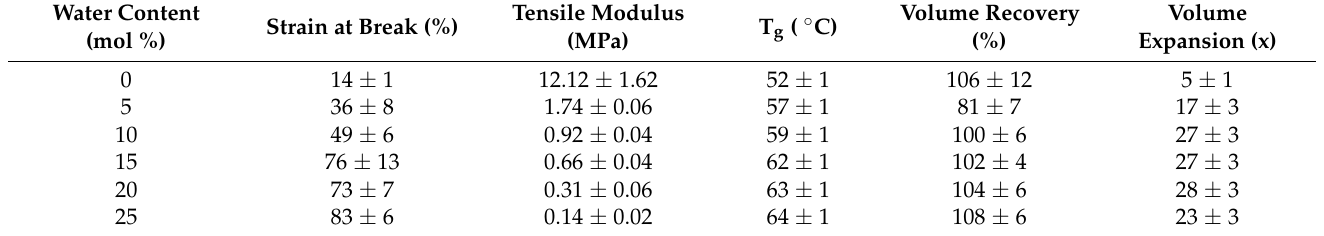
Table 3. Physical properties of SMP foams with varying water content.